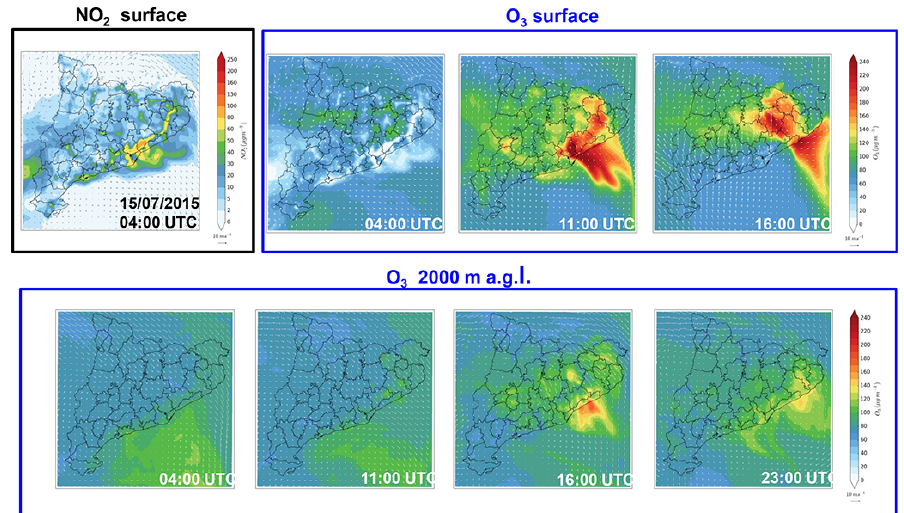
Figure 16. Maps of simulated NO 2 and O 3 concentrations at ground level with wind vectors at 10ma.g.l. and at 2000ma.g.l. with wind vectors at the same altitude, for selected hours on 15 July